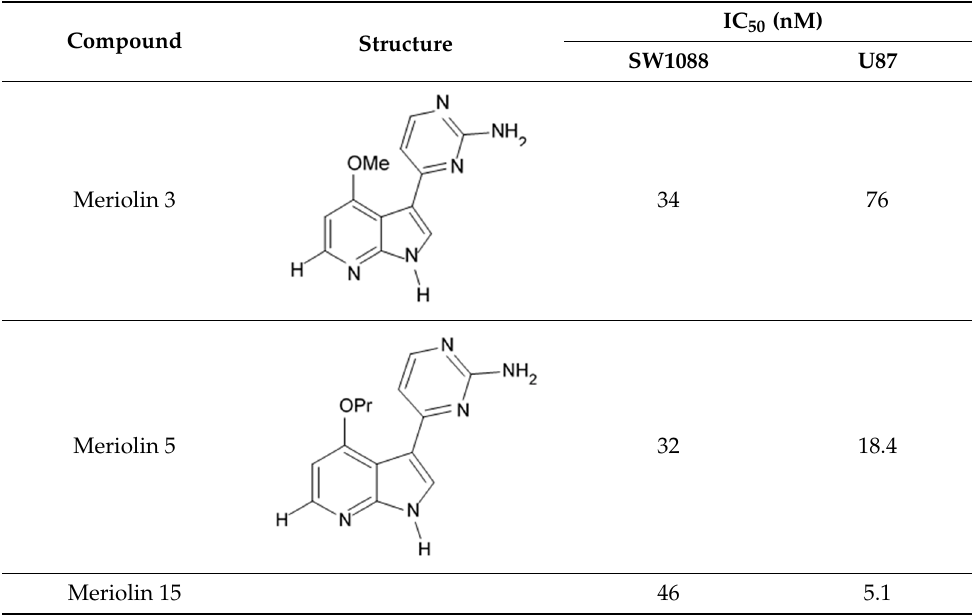
Table 2. Structure and cytotoxic effects of meriolins against glioma cell lines [51]. Compound Structure Compound